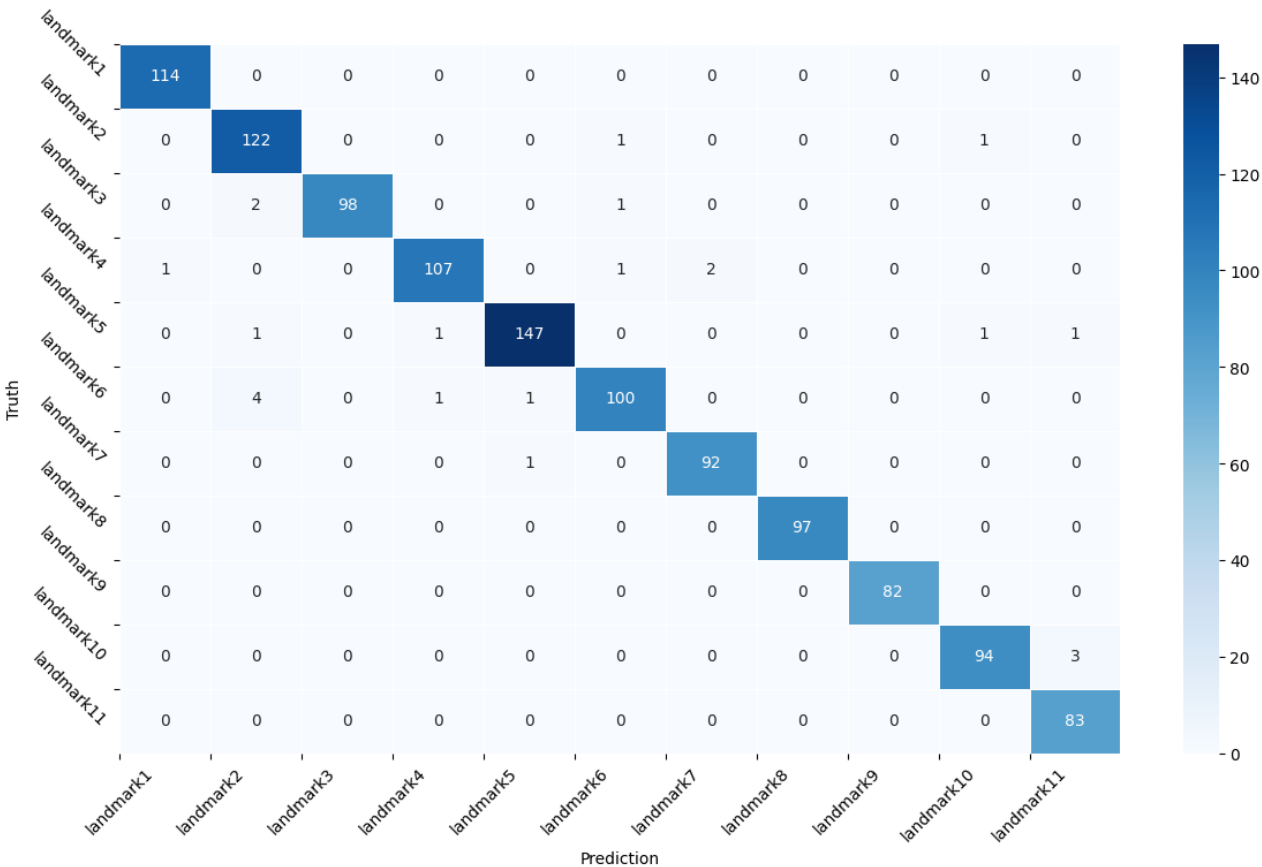
Figure 5. Accuracy ( a ) and loss ( b ) curves of the model on the selected parameters.